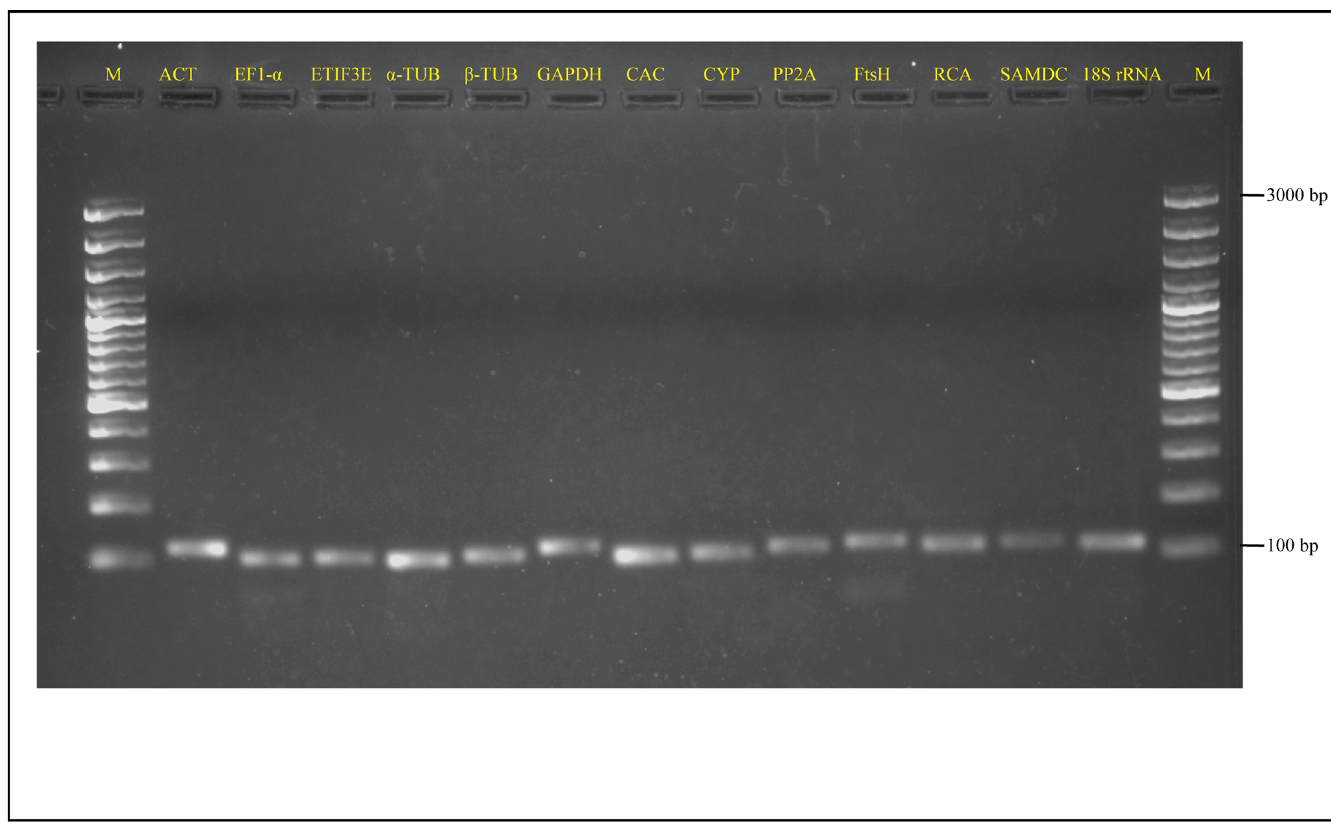
Fig 1. Agarose gel (2%) electrophoresis showing PCR amplified products of the expected size for 13 candidate reference genes. M: 100 bp marker (Thermo Scientific).